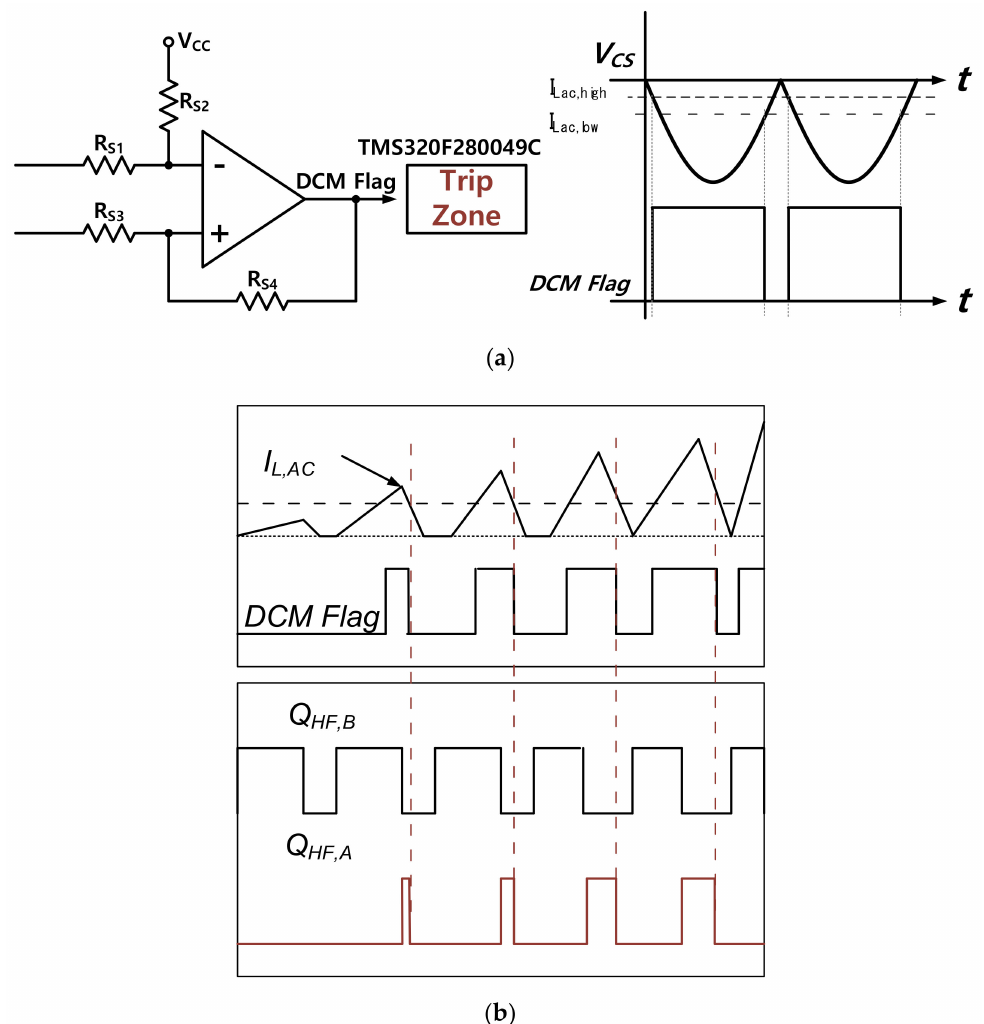
Figure 4. Proposed CBC trip-type synchronous PWM operation method. ( a ) Schmitt trigger circuit for DCM flag and ( b ) proposed synchronous PWM